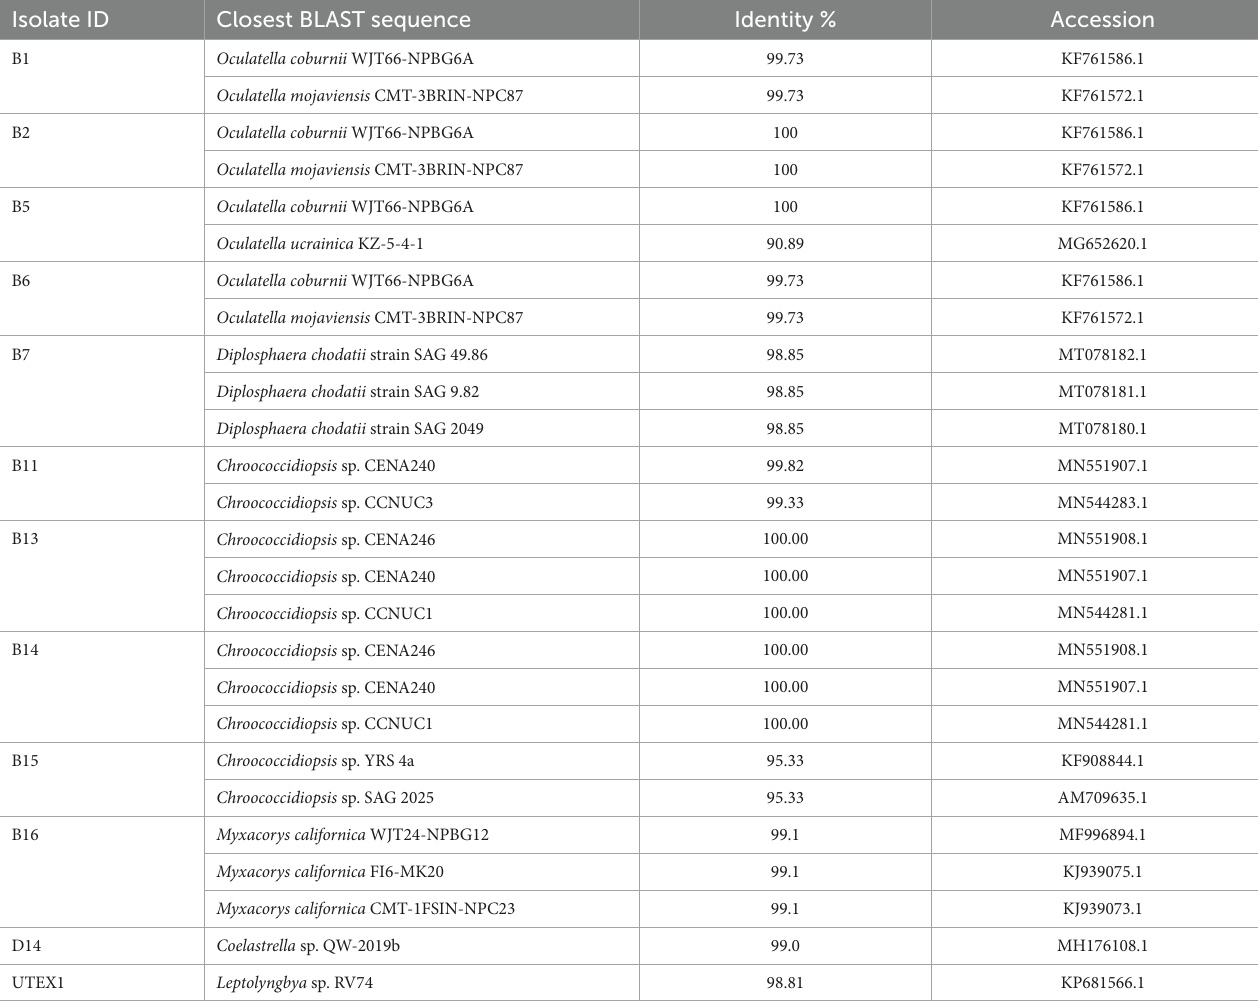
TABLE 2 BLAST results obtained by querying the 16S/18S rRNA gene of the different cyanobacteria from a solar panel with GenBank. Isolate ID Closest BLAST sequence Identity